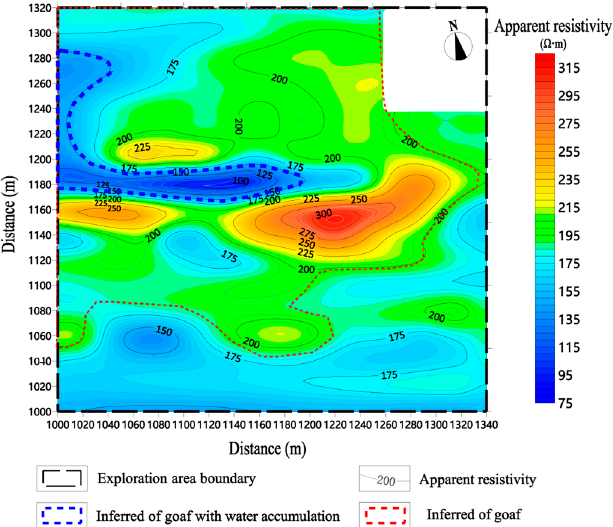
Figure 9. Bedding-Section Map of Pseudo-Apparent Resistivity of Prospected Coal Seam.